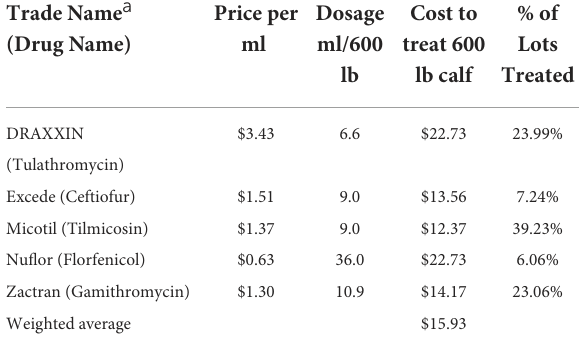
TABLE 2 Metaphylaxis treatments used by a U.S. Southern Plains